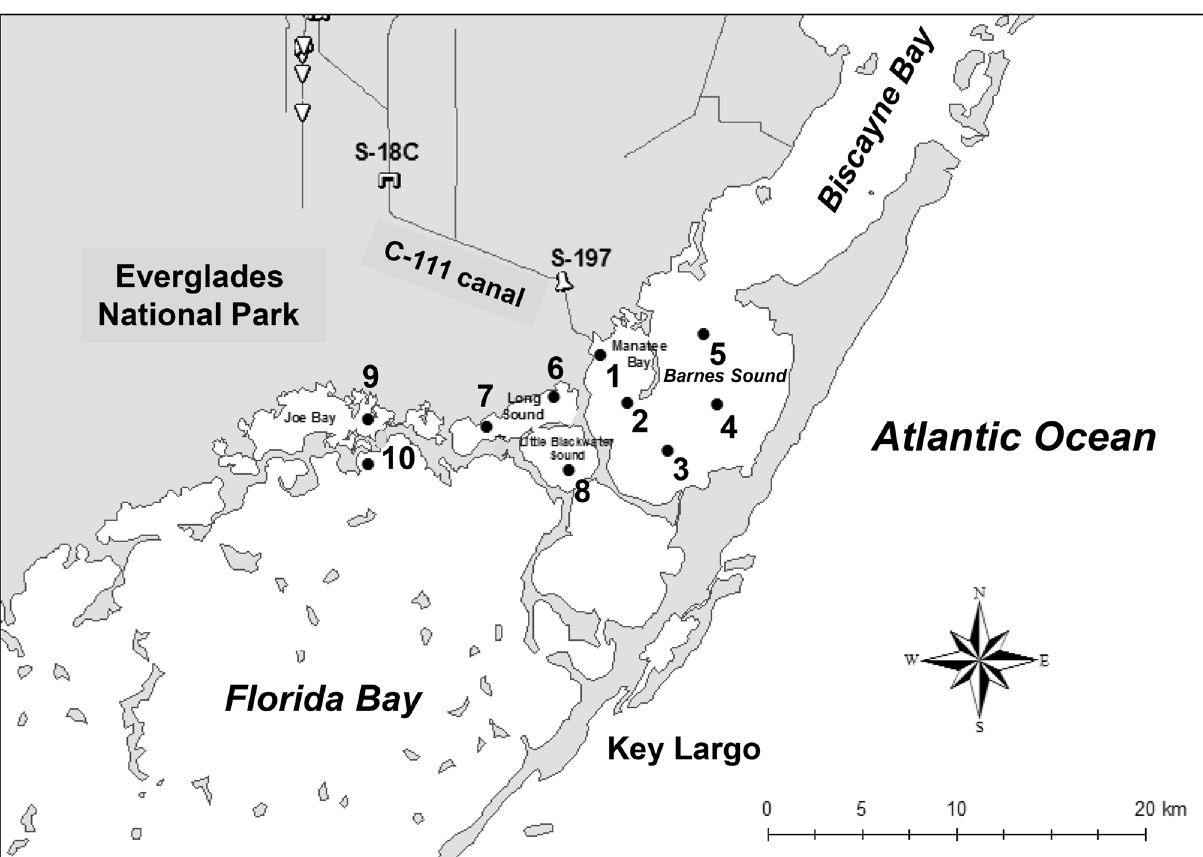
Figure 1. Map of sample regions and study sites (map was based on ArcMap Version 10.7 base